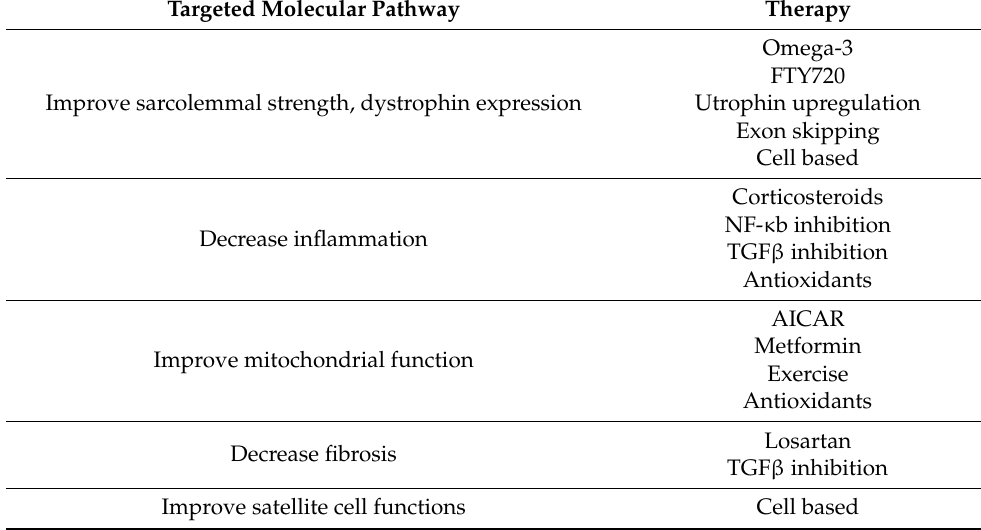
Table 2. Multiple muscular dystrophy